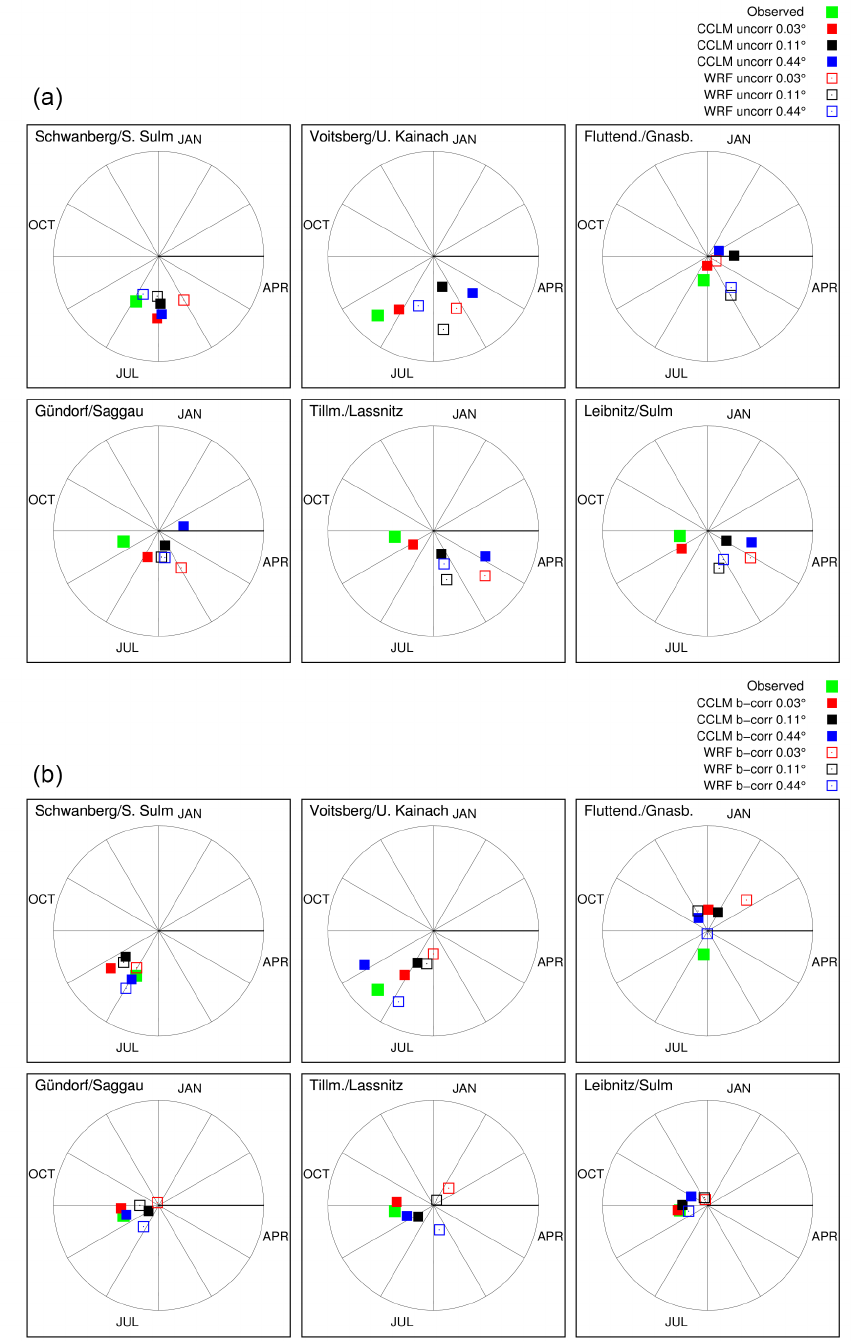
Figure 17. Results of seasonality (circular statistics of the maximum annual floods) evolving the different model runs. (a) Raw RCM data as input; (b) bias-corrected RCM data as input. The distance from the centre is the mean vector r and a measure for the seasonality strength, i.e. concentration of